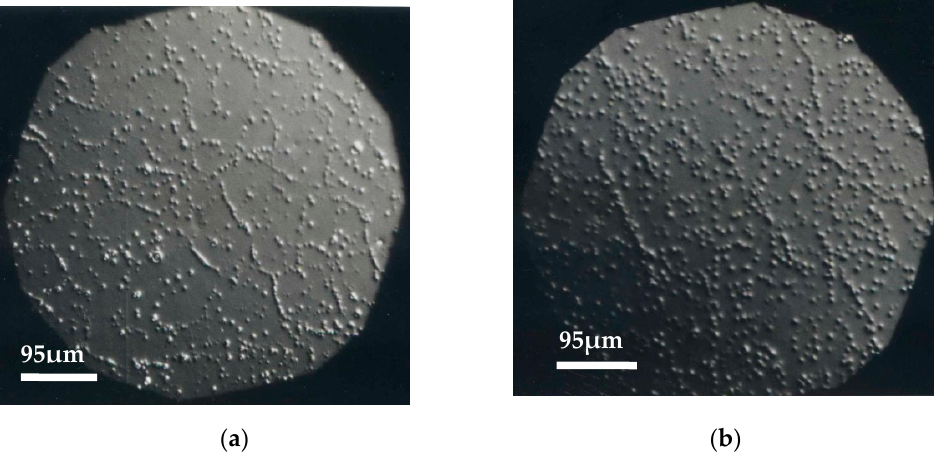
Figure 3. ( a ) Cd 0.90 Zn 0.10 Te, v = 3.32 mm/h, δ = 6.6 × 10 5 cm − 2 , φ = 26 ″ ; ( b ) Cd 0.90 Zn 0.10 Te, v = 1.66 mm/h, δ = 6.9 × 10 5 cm − 2 , φ = 19 ″ . Table 1. CZT atomic fraction, growth rate, grains number, average dislocations density ( δ ), and average contiguous subgrains misorientation ( φ ) are shown for each ingot. The average dislocations density ( δ ) and the average contiguous subgrains misorientation ( φ ) are also shown for some [111] wafers.